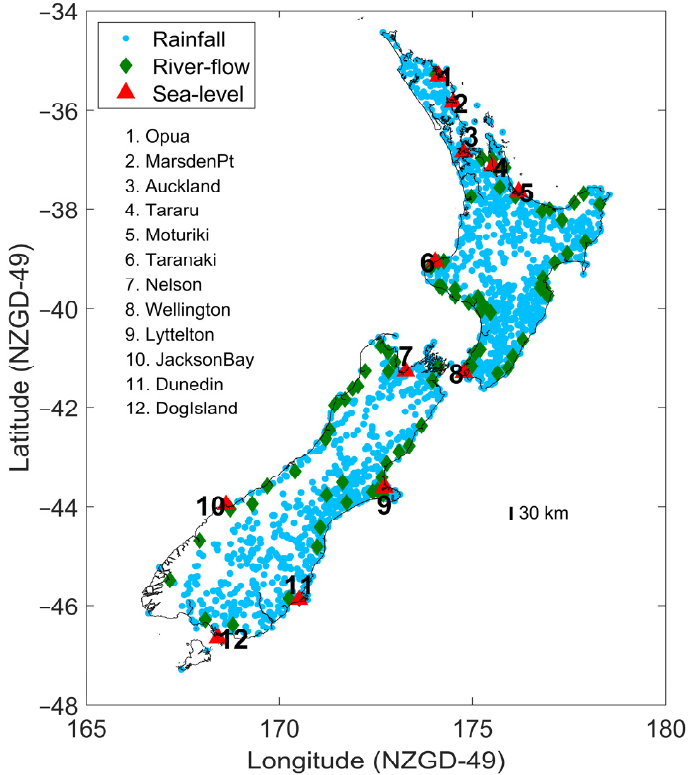
Figure 1. Location of rainfall (blue), river flow (green), and sea level (red) records used. Sea level recorder locations 1–12 are labelled.